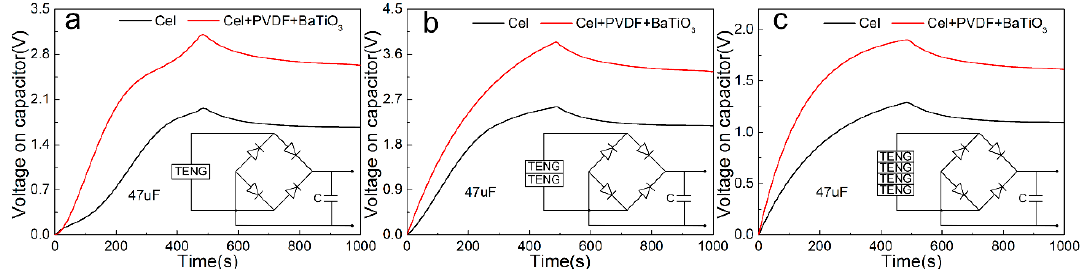
Figure 9. Charging and discharging performance test of different numbers of friction layers: ( a ) single, ( b ) two ( c ) four.